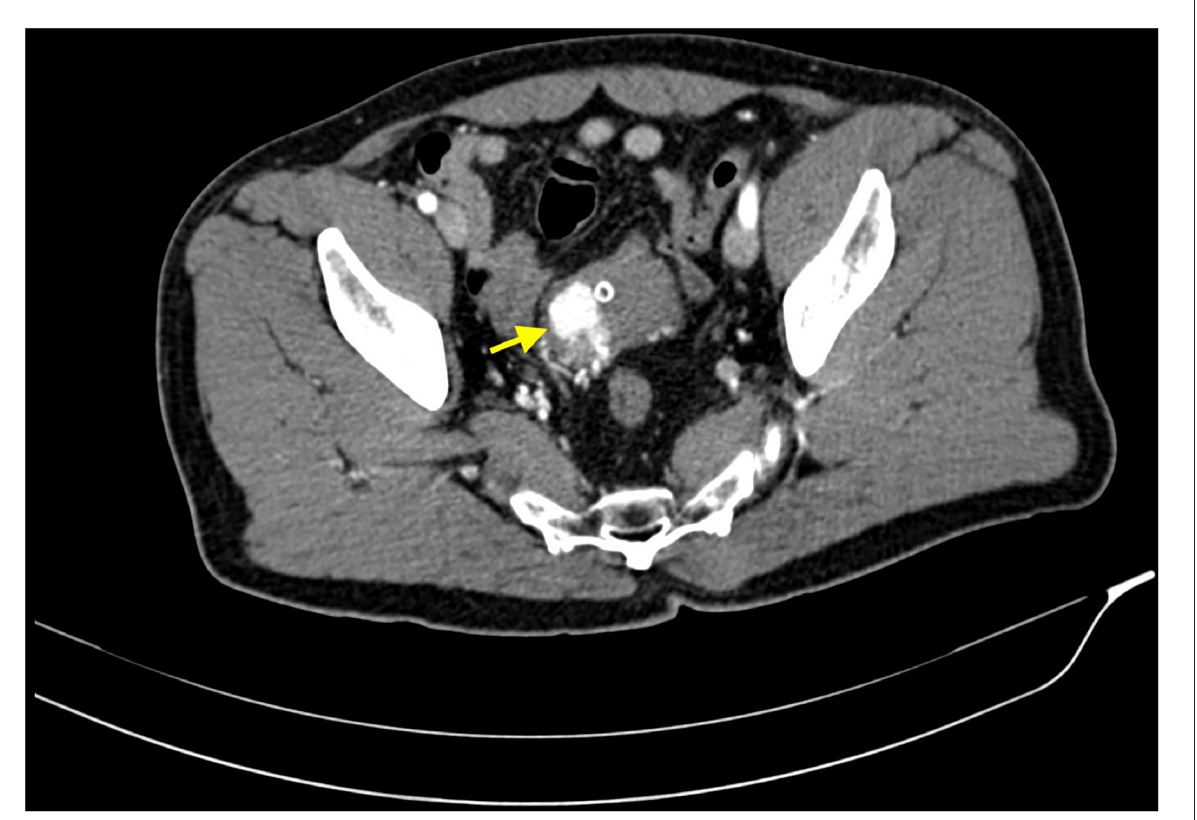
FIGURE1 CT scan acquired in arterial phase, after intravenous administration of iodinated contrast media. This image shows a highly vascular lesion within the right wall of the bladder dome (yellow arrow). Some small feeding arteries are appreciable too. The bladder is empty due to urinary catheterization via Foley